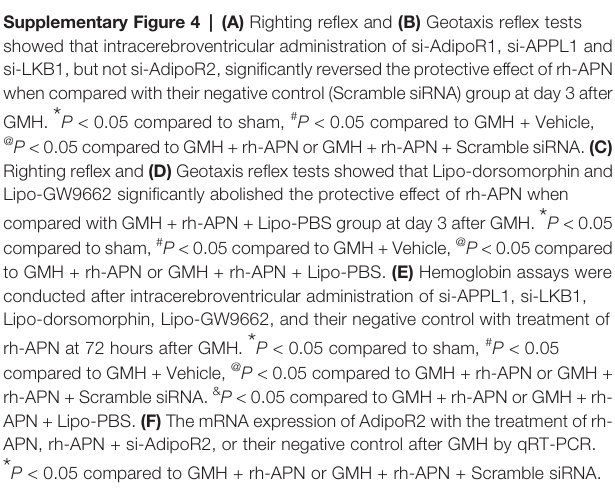
Supplementary Figure 1 | Timeline of experiment design. GMH, Germinal matrix hemorrhage; WB, Western Blot; rh-APN, recombinant human Adiponectin. Supplementary Figure 2 | Representative images of immuno fl uorescence staining showing the co-localization of Adiponectin (red) and AdipoR1 (red) with astrocyte ( A , GFAP, green) in the pups with or without GMH. Immunoreactivities of Adiponectin and AdipoR1 were greater on astrocytes in the periventricular area. Arrows indicate co-localization of Adiponectin or AdipoR1 with astrocytes. Scale bar=50 m m.n=3foreach group. (B, C) qRT-PCR analysisshowedmRNAlevelsof Adiponectin (B) and AdipoR1 (C) , not AdipoR2 (D) increased signi fi cantly at 12 h after GMH when data were normalized to GAPDH.Values are expressed as mean ± SD. ANOVA, Dunnett. n = 6 for each group. * P < 0.05 compared to sham. Supplementary Figure 3 | (A – D) Quanti fi cations of Nissl-stained brain sections showingrh-APNsigni fi cantlyreducedventricularvolume (A,B) andthewhitematter loss (C) , while increased (D) cortical thickness in pups with GMH. (E) The ratio of CD68 + Iba1 + M1-like cells and CD206 + Iba1 + M2-like cells after GMH with rh-APN treatment or rh-APN + Scramble siRNA or rh-APN + si- AdipoR1. Values are expressed as mean ± SD. ANOVA, Dunnett. n = 8 for each group. * P < 0.05 compared tosham, # P < 0.05compared toGMH+Vehicle, @ P <0.05compared to GMH + rh-APN or GMH + rh-APN + Scramble siRNA. Supplementary Figure 4 | (A) Righting re fl ex and (B) Geotaxis re fl ex tests showed that intracerebroventricular administration of si-AdipoR1, si-APPL1 and si-LKB1, but not si-AdipoR2, signi fi cantly reversed the protective effect of rh-APN when compared with their negative control (Scramble siRNA) group at day 3 after GMH. * P < 0.05 compared to sham, # P < 0.05 compared to GMH + Vehicle, @ P < 0.05 compared to GMH + rh-APN or GMH + rh-APN + Scramble siRNA. (C) Righting re fl ex and (D) Geotaxis re fl ex tests showed that Lipo-dorsomorphin and Lipo-GW9662 signi fi cantly abolished the protective effect of rh-APN when compared with GMH + rh-APN + Lipo-PBS group at day 3 after GMH. * P < 0.05 compared to sham, # P < 0.05 compared to GMH + Vehicle, @ P < 0.05 compared to GMH + rh-APN or GMH + rh-APN + Lipo-PBS. (E) Hemoglobin assays were conducted after intracerebroventricular administration of si-APPL1, si-LKB1, Lipo-dorsomorphin, Lipo-GW9662, and their negative control with treatment of rh-APN at 72 hours after GMH. * P < 0.05 compared to sham, # P < 0.05 compared to GMH + Vehicle, @ P < 0.05 compared to GMH + rh-APN or GMH + rh-APN + Scramble siRNA. & P < 0.05 compared to GMH + rh-APN or GMH + rh- APN + Lipo-PBS. (F) The mRNA expression of AdipoR2 with the treatment of rh- APN, rh-APN + si-AdipoR2, or their negative control after GMH by qRT-PCR. * P < 0.05 compared to GMH + rh-APN or GMH + rh-APN + Scramble